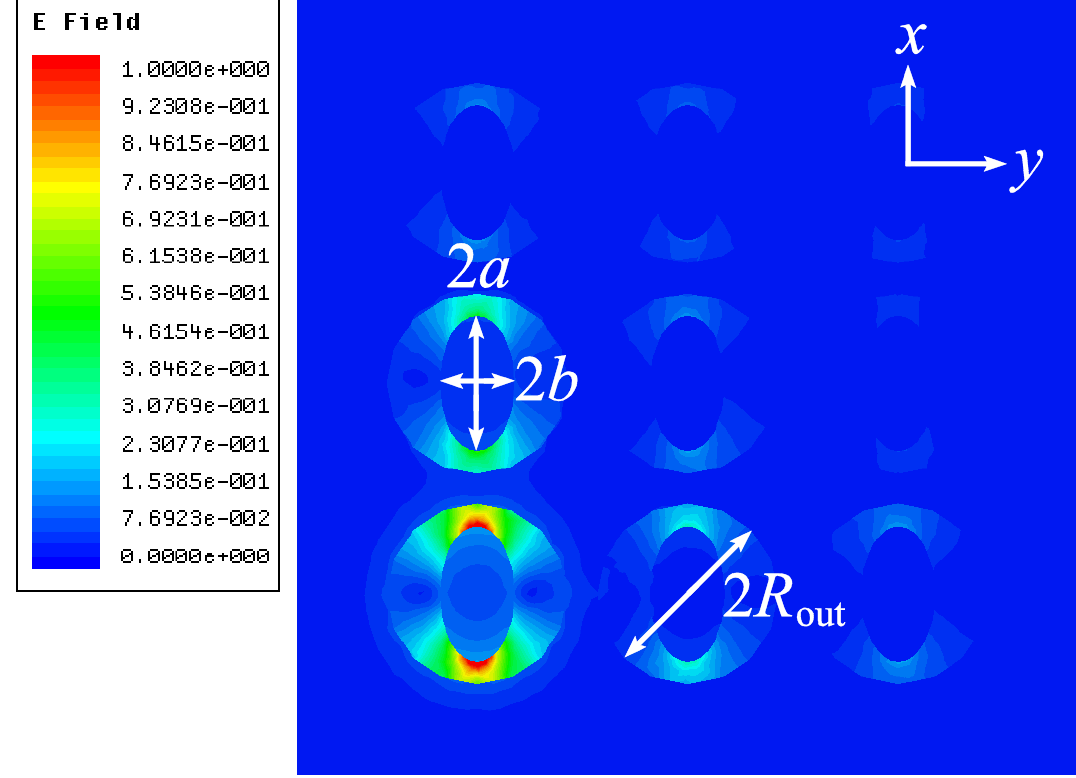
Figure 13. | E(x,y,z) |, the phase-dependent modulus of the electric field in an array of coaxials; a = 25 nm, b = 45 nm and R